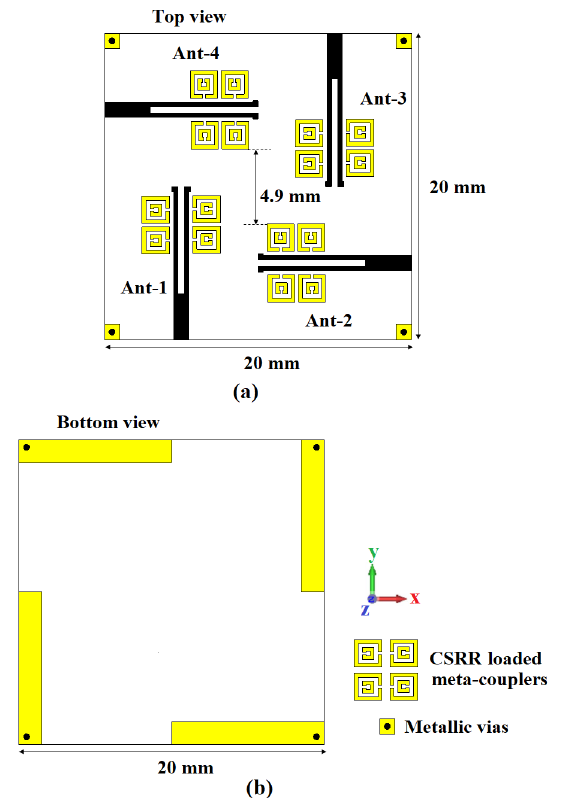
Figure 5. Proposed four-element antenna configuration: ( a ) top view and ( b ) bottom view.